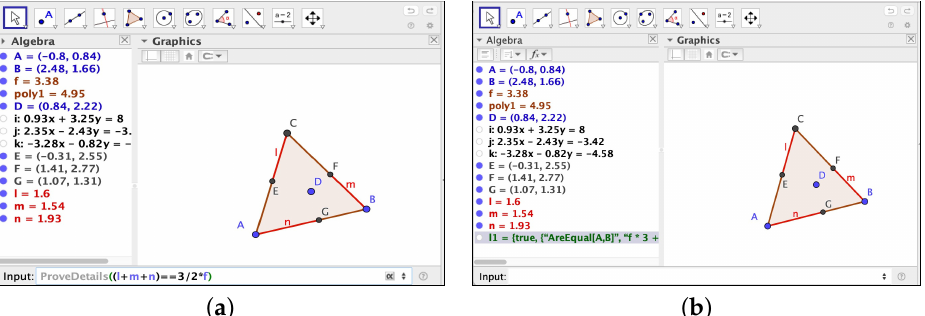
Figure 3. ( a ) Asking GeoGebra Discovery to prove that the sum l + m + n is equal to the semiperimeter 3/2 f . ( b ) GeoGebra Discovery replies that the statement is true except in some degenerate cases (described in the list after true in the last line of the Algebra